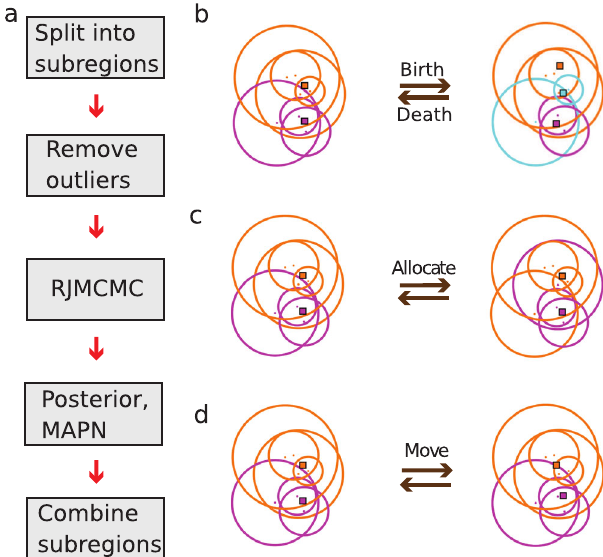
Fig. 1 | Bayesian grouping of localizations concept and data fl ow. Circles are centered on given localizations with radii equal to two times the corresponding localization precisions. Colors represent localization allocations to emitters. Squares show emitters. a The data fl ow. The RJMCMC step is illustrated in further detail in panels b – d . b From left to right, addition of a new emitter (blue) in a randomlocationisproposedviaa Birth jump.Fromrighttoleft,anexistingemitter is picked randomly and is eliminated from the model via a Death jump. c Localizations are redistributed across the emitters via an Allocation jump while emitter positions are fi xed. d Given a fi xed set of allocations, all emitter positions are updated in a Move